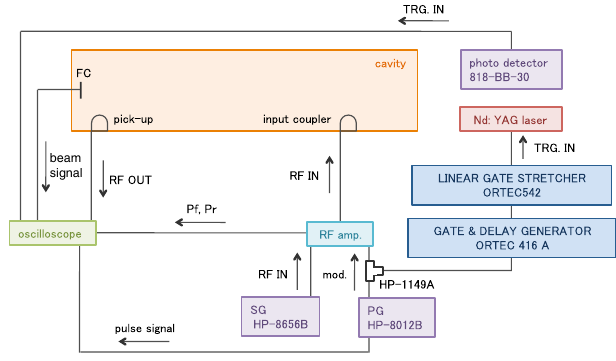
FIG. 28. Layout of the beam acceleration system. SG and PG refer to a signal generator and pulse generator, respectively.